Question: In one sentence, what is this figure communicating?
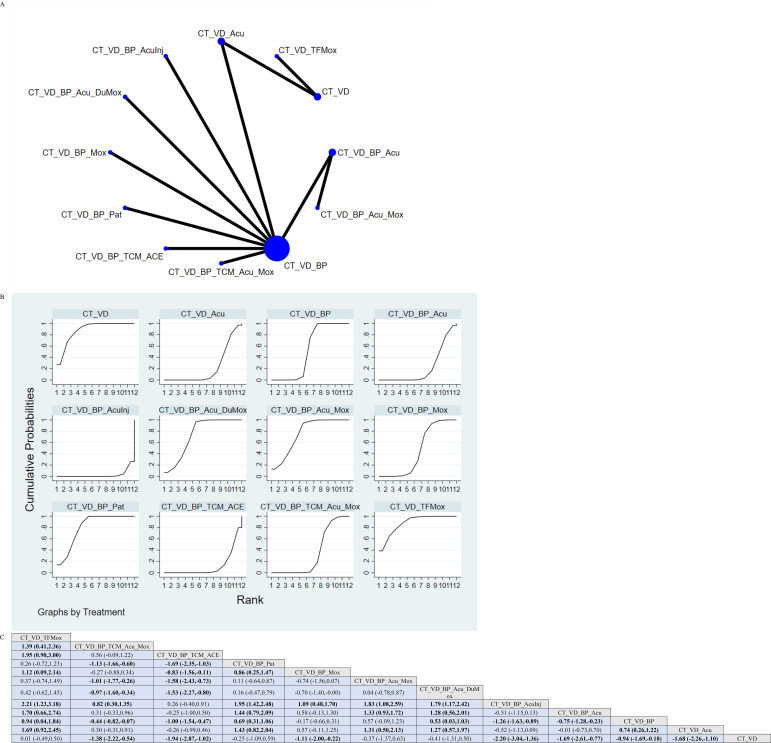
Answer: Network meta-analysis of PINP (A) Network plot of the network meta-analysis for PINP. (B) Rankogram of overall intervention strategies from the network meta-analysis for PINP. (C) League table of the network meta-analysis for PINP.